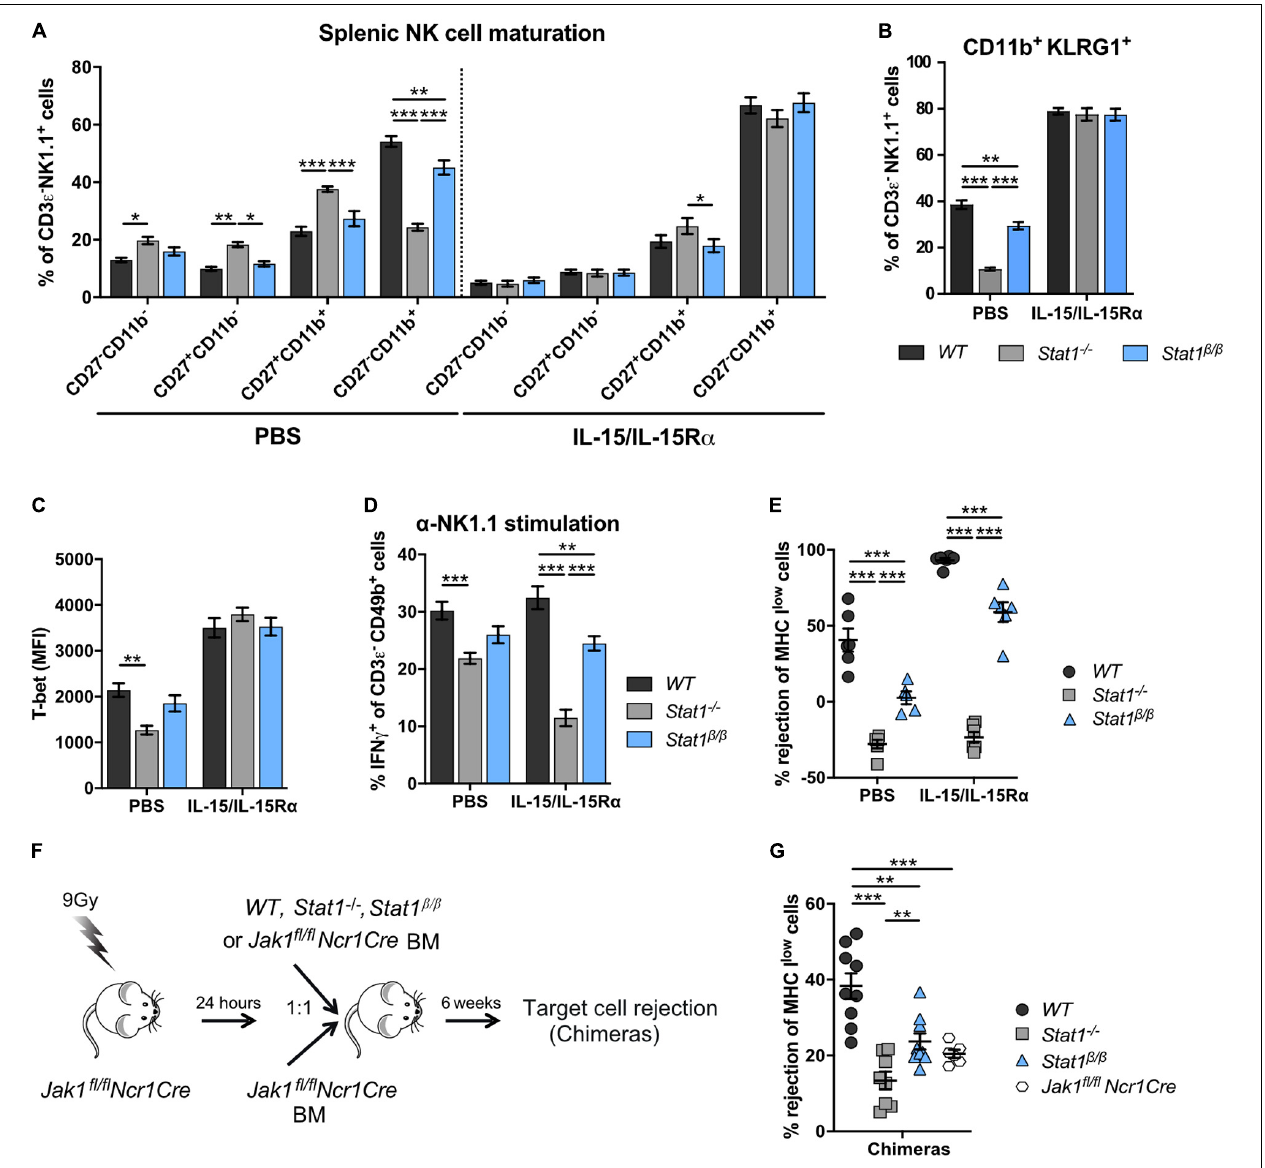
FIGURE 6 | Treatment with exogenous IL-15/IL-15R α complexes rescues NK cell maturation but not functionality in Stat1 − / − and Stat1 β / β mice and development of NK cells from Stat1 − / − and Stat1 β / β mice in a STAT1-proficient environment does not rescue in vivo NK cell cytotoxicity. (A–E) WT , Stat1 − / − , and Stat1 β / β mice were treated with PBS or with IL-15/IL-15R α for 1 week. Splenic NK cells (CD3 ε − NK1.1 + ) of these mice were analyzed for the maturation subsets CD27 − CD11b − , CD27 + CD11b − , CD27 + CD11b + , and CD27 − CD11b + (A) , CD11b + KLRG1 + (B) , and intracellular T-bet levels (C) . Mean percentages ± SEM ( n = 11–12) from four experiments (A,B) and mean MdFIs ± SEM ( n = 6) from two experiments (C) are shown. Splenocytes from PBS or IL-15/IL-15R α treated mice were analyzed for IFN γ production in response to NK1.1 stimulation as described in the legend to Figure 3D (D) and in vivo cytotoxicity assay was performed (E) . Mean percentages ± SEM from three ( n = 9) (D) and two ( n = 6) (E) experiments are shown. For simplicity, statistical significances are only indicated for genotype comparisons (A–E) . (F) Scheme illustrating mixed bone morrow chimera experiments. (G) Bone marrow chimeric mice (chimeras) and Jak1 fl / fl Ncr1Cre controls were used for in vivo NK cell cytotoxicity assays using MHC I low target cells as described in the legend to Figure 3C . Mean percentages ± SEM ( n = 6–10) from three experiments are shown (G) . * p < 0.05; ** p < 0.01; *** p < 0.001.